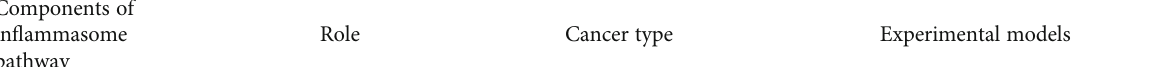
Table 1: Correlation between the roles of various in fl ammasome pathway components in cancer migration, growth, and metastasis. Components